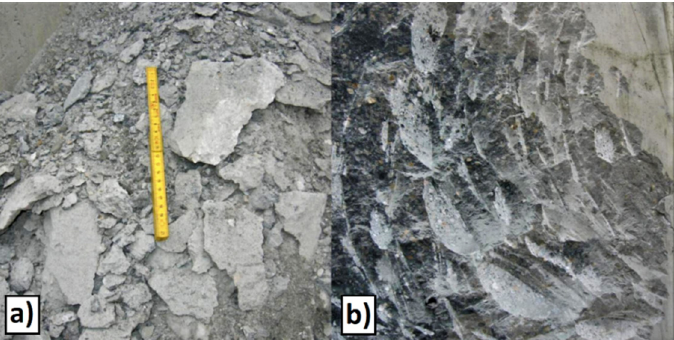
Figure 23. View of the mining results with the use of a new mining head: ( a ) the view of the obtained output, ( b ) the view of the specific surface of the mined concrete block (intersection of the grooves) [31].